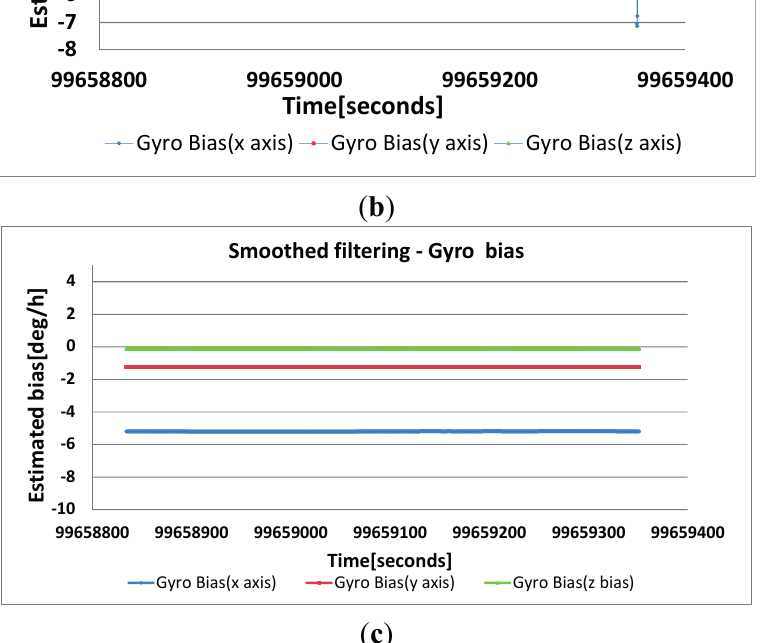
Figure 8. Post-processed attitude results (quaternion) (the785th track). ( a ) The gyro bias of forward filtering; ( b ) the gyro bias of backward filtering; ( c ) The gyro bias of smoothed